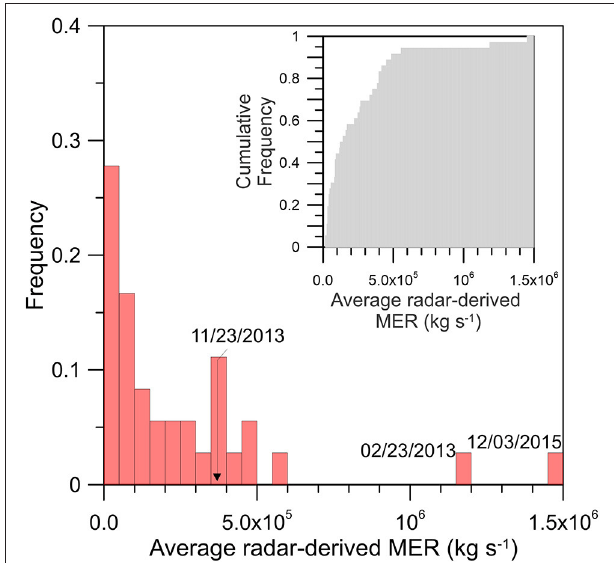
FIGURE 8 | Frequency distribution of the 47 average radar-derived Mass Eruption Rates (MERs) considering the whole duration of each paroxysm. Inset: Cumulative plot of the average radar